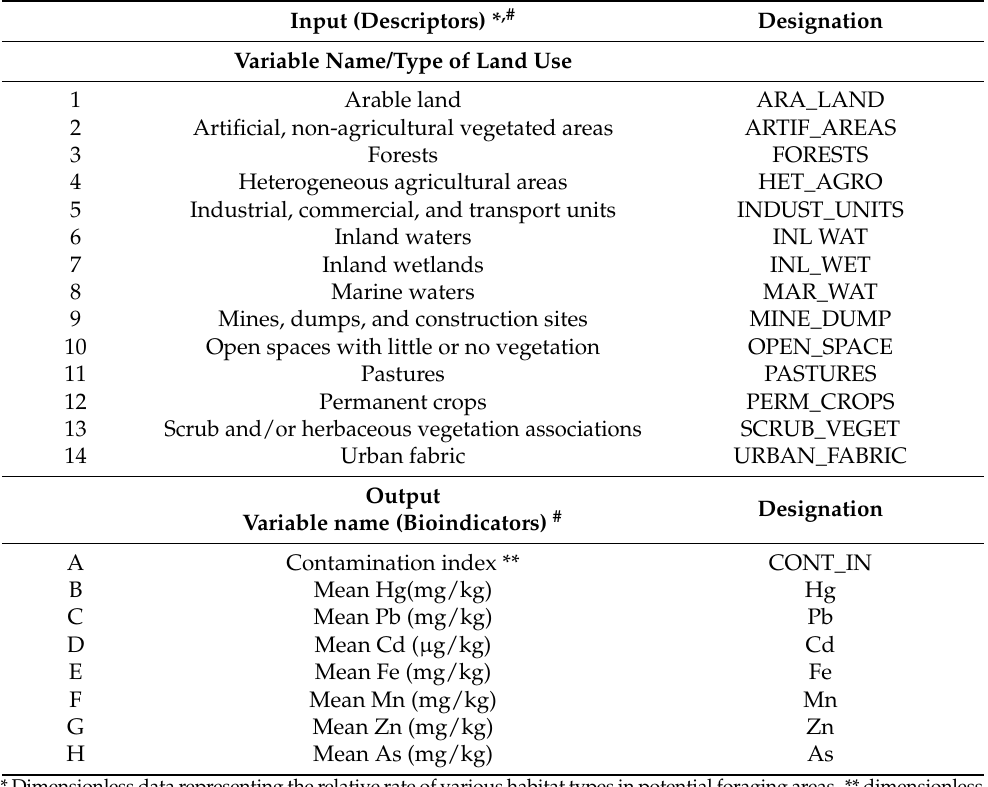
Table 1. Input and output variables of